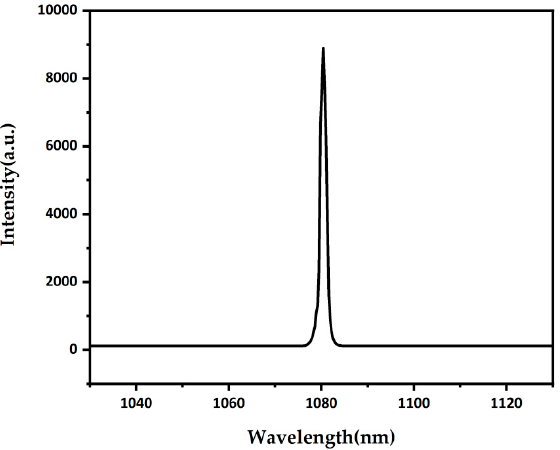
Figure 8. The laser emission spectrum of Nd:GYAP laser in Q-switching regimes.